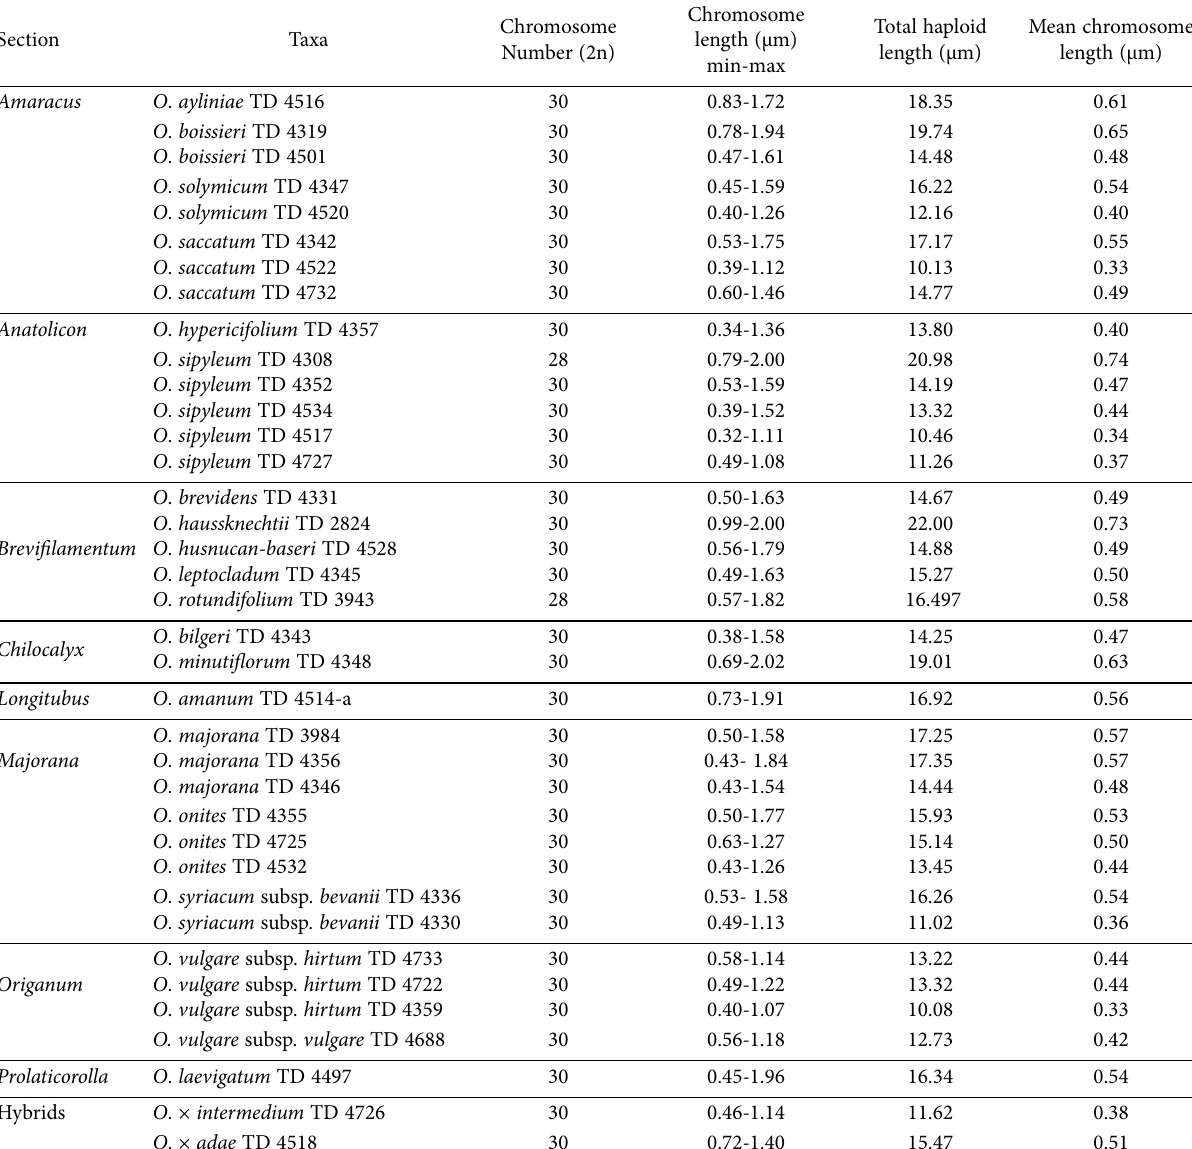
Table 1. Chromosome counts and size of species and hybrids of Origanum determined in the study.